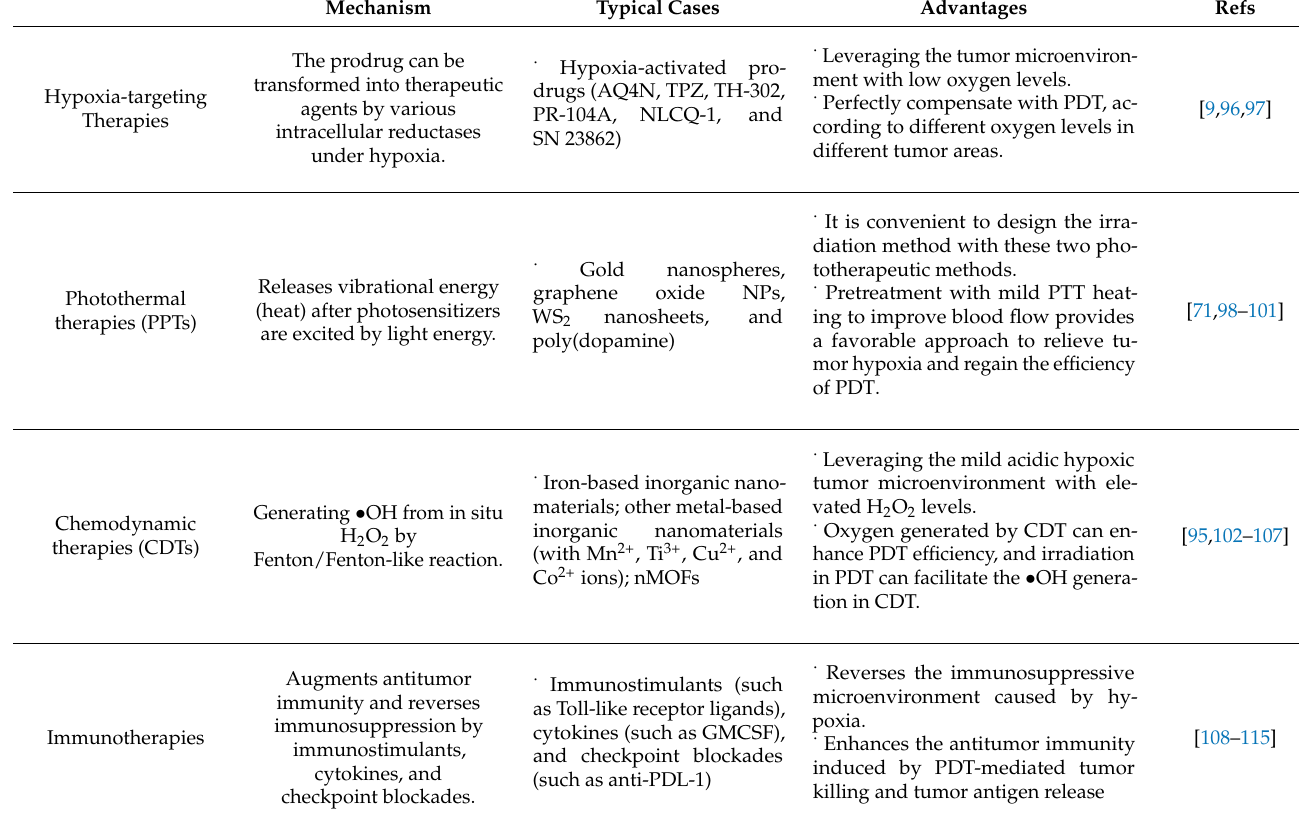
Table 1. Summary of therapies usually combined with